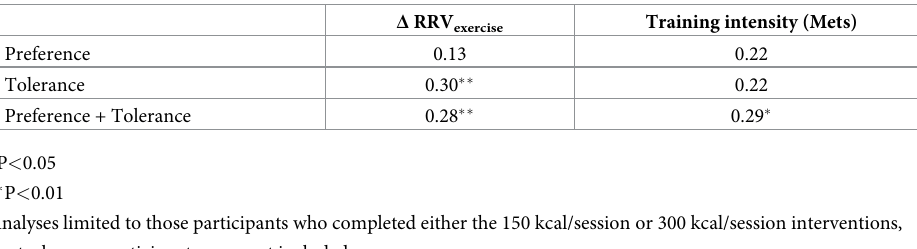
Table 3. Simple (Pearson) correlations (r) between the changes in preference and tolerance for exercise intensity and the change in RRV exercise from baseline to after 6-weeks of exercise training and correlations between the changes in preference and tolerance for exercise intensity and the average intensity of exercise